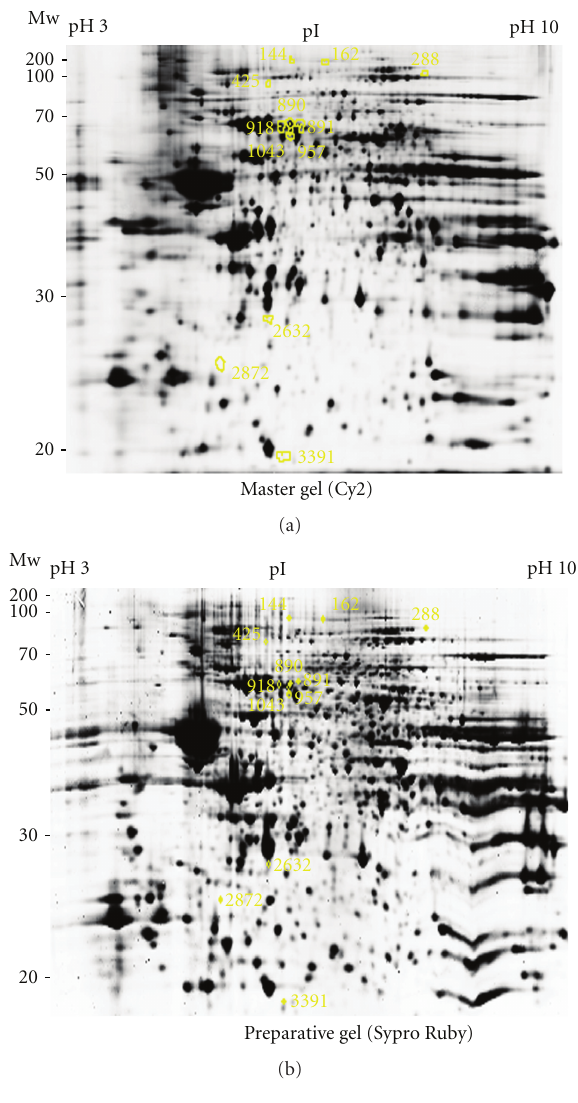
Figure 1: 2-DE map of the di ff erentially expressed protein spots. The figure shows the position on the master (a) and on the prepara- tive (b) gels of the 12 deregulated spots, according to the di ff erential expression analysis of proteins from wild-type and FDD KI mouse synaptosomes. In (a), the deregulated spots are surrounded by a yellow border; matched spots within the preparative gel (b) are highlighted by a yellow circle, which also denotes the picking surface for the robotic spot picker. The representative image reported in (a) shows the Cy2-labelled proteins on the scanned master gel; protein spots in (b) were visualized by Sypro Ruby fluorescent staining. Mw: molecular weight; pI: isoelectric